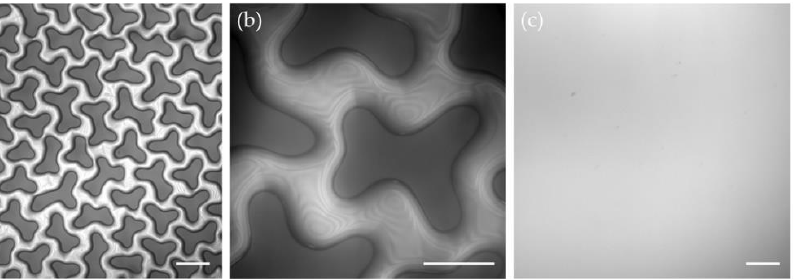
Figure 6. Microscope images of the contact areas. ( a ) A microscope image of the contact area when a glass coverslip was indenting a 19-micrometer-thick substrate with instability patterns. ( b ) Zoomed-in view of the contacts in ( a ) with an interference microscope. The interference fringes were induced by the trapped-air cavities. ( c ) A microscope image of contact area when a glass coverslip was indenting a 19-micrometer-thick substrate without the instability patterns. The scale bars in ( a , c ) are 100 µm. The scale bar in ( b ) is 50 μm.